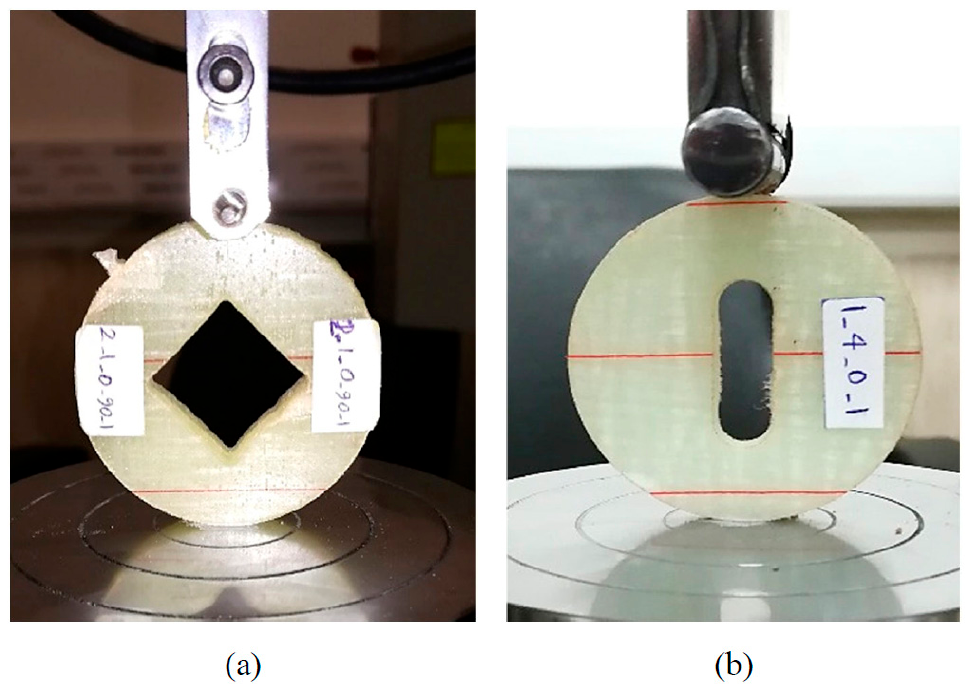
Figure 3. Setup configuration used for conducting Brazilian disk tests; ( a ) V-notched specimen (90°); ( b ) U-notched specimen. Table 2. Experimental fracture loads (N) of unidirectional composite Brazilian disks.